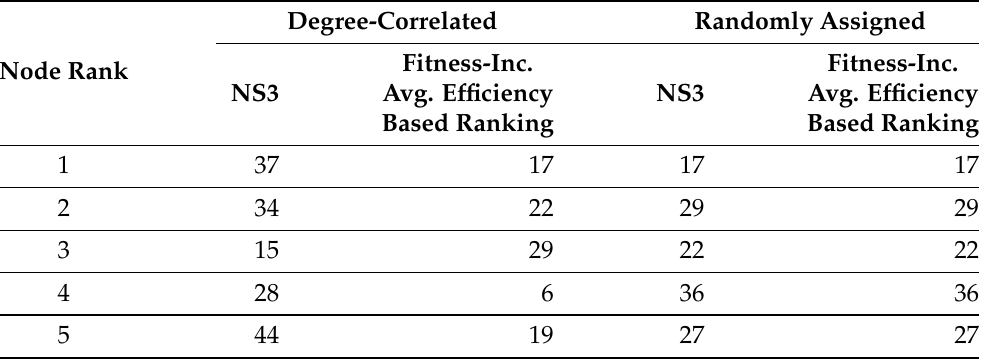
Table 7. Node ranking comparison in the scale-free topology, based on average efficiency, when the node fitness is distributed in a degree-correlated and a random manner. Degree-Correlated Randomly Assigned Node Rank